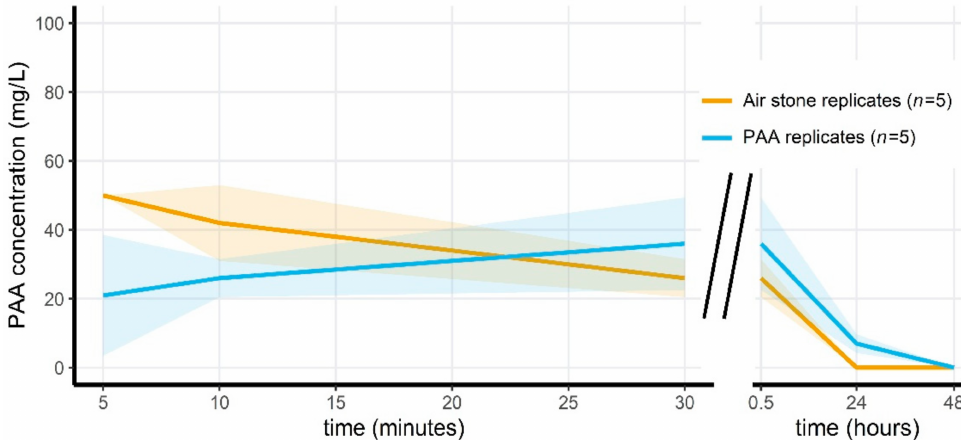
Figure 4. Mean measured peracetic acid concentration through time for the first 30 min (( left ) in minutes) and for 24 and 48 h afterwards (( right ) in hours) during the second microcosm exposure experiment. Shaded areas indicate the mean ± standard deviations. Measurements were taken at 5, 10 and 30 min, and every 24 h afterwards. Orange data is obtained from replicates that had an air stone and were treated with PAA, blue data is from the replicates that did not have an air stone and were treated with